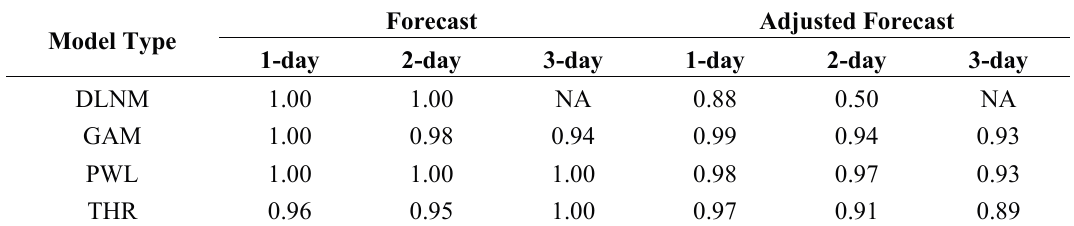
Table 3. Positive prediction values for the four models using forecast and adjust forecasted temperatures, and different issuing time